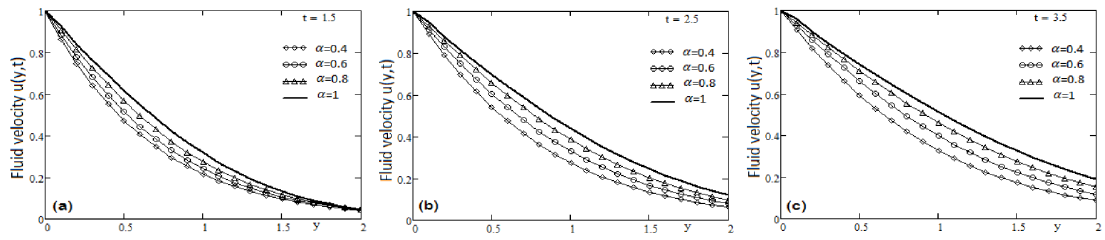
Figure 3. Profiles of velocities for Reynolds number variation for different time and fixed fractional parameter α = 0.5